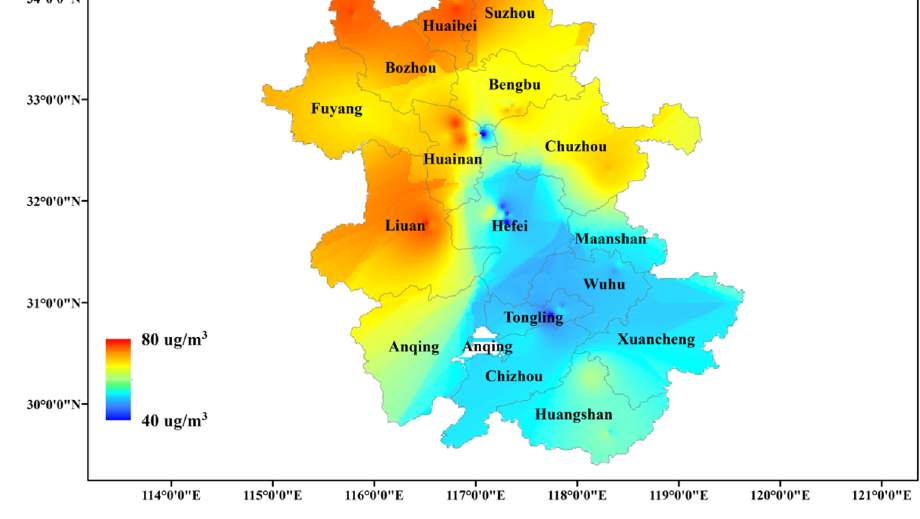
Fig. 1 Spatial distribution char- acteristics of O concentrations 3 in Anhui Province in 2020. The colours represent the annual average of ozone concentra-